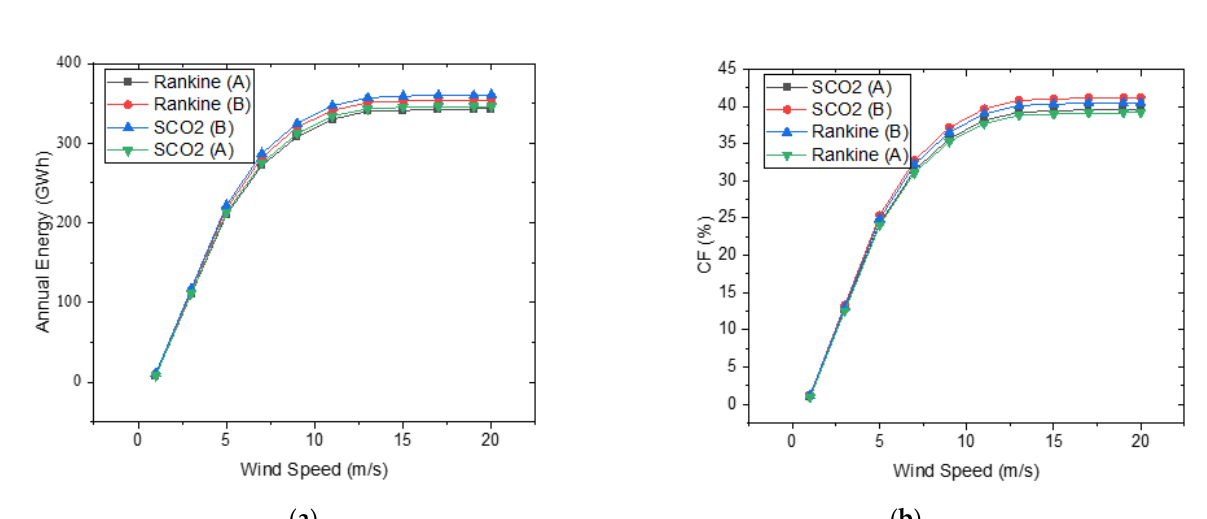
Figure 7. Effect of wind stow speed on the annual energy ( a ) and capacity factor ( b ) on the various scenarios.